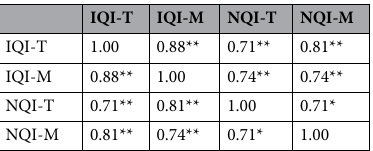
Table 5. Correlation matrix for the eight SQI. **Correlation is significant at the 0.01 level. *Correlation is significant at the 0.05